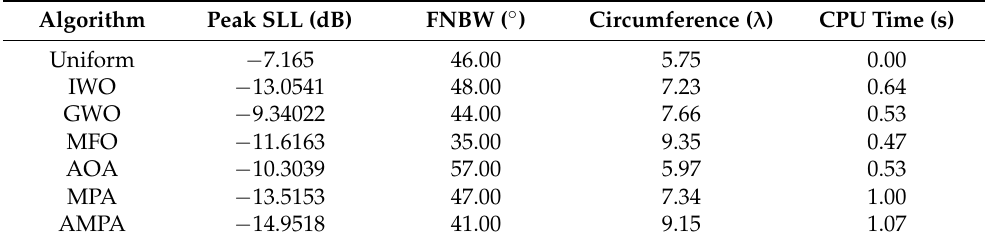
Table 6. Optimization results of 12-element CAA obtained by different algorithms for PSLL minimization.